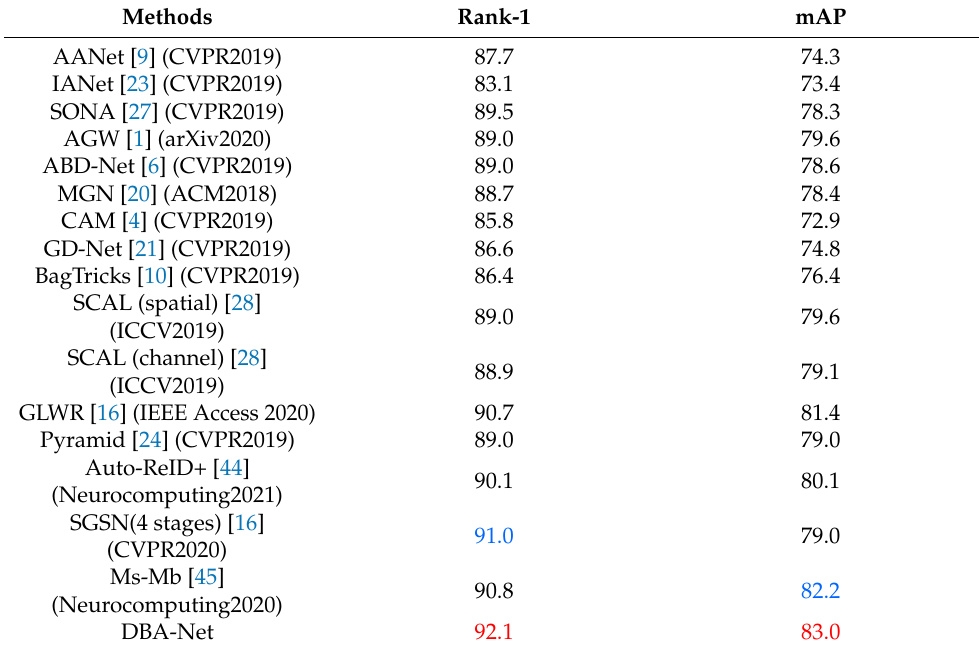
Table 4. Comparison with the SOTA methods on the DukeMTMC-ReID. The best performance is shown in red, and the second best performance is shown in blue.